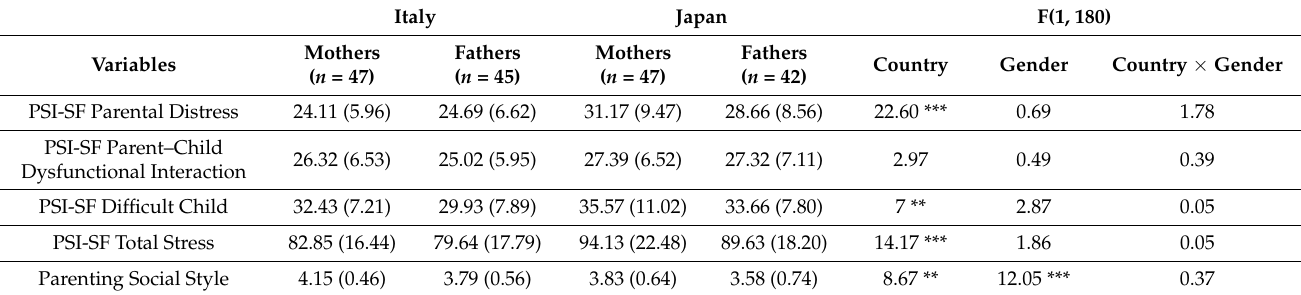
Table 2. Descriptive statistics of variables of Italian and Japanese